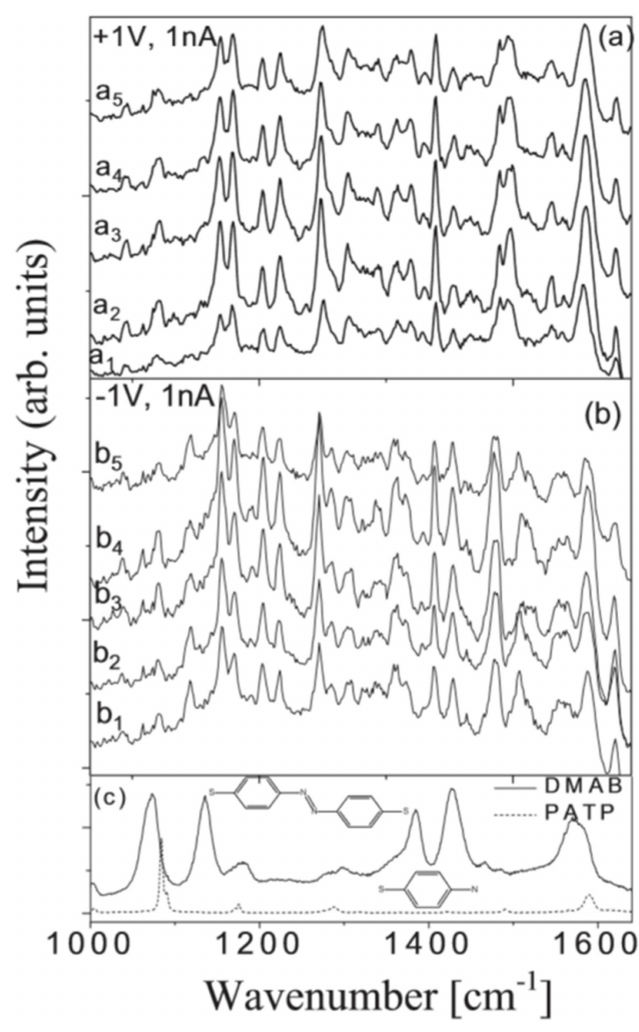
Figure 6. HV-TERS of PATP measured under 1 nA current and ( a ) +1 V, and ( b ) − 1 V bias voltage at different positions, ( c ) SERS spectrum of DMAB in Au sol and NRS of PATP [68]. Comparing the experimental TERS spectrum with calculated Raman and IR spectra in Figure 7 shows that all of the peaks can be assigned and the IR-active modes are activated, owing to the electric field gradient effect (molecular quadrupole